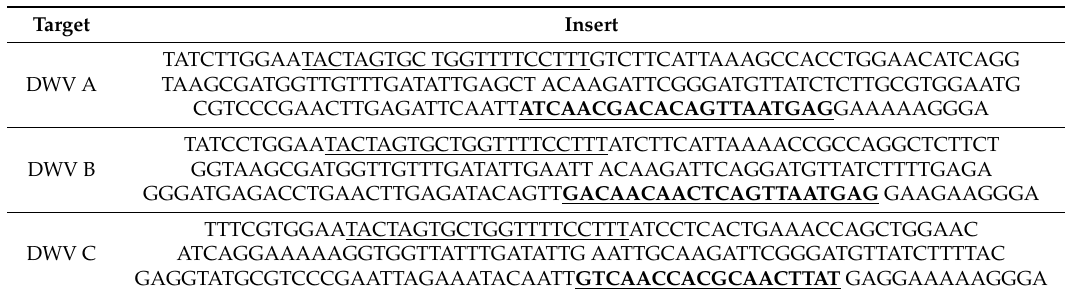
Table 2. DWV master variant (A, B, C) insert used in the plasmids. Primer sequences are underlined and reverse primer sequences are highlighted in